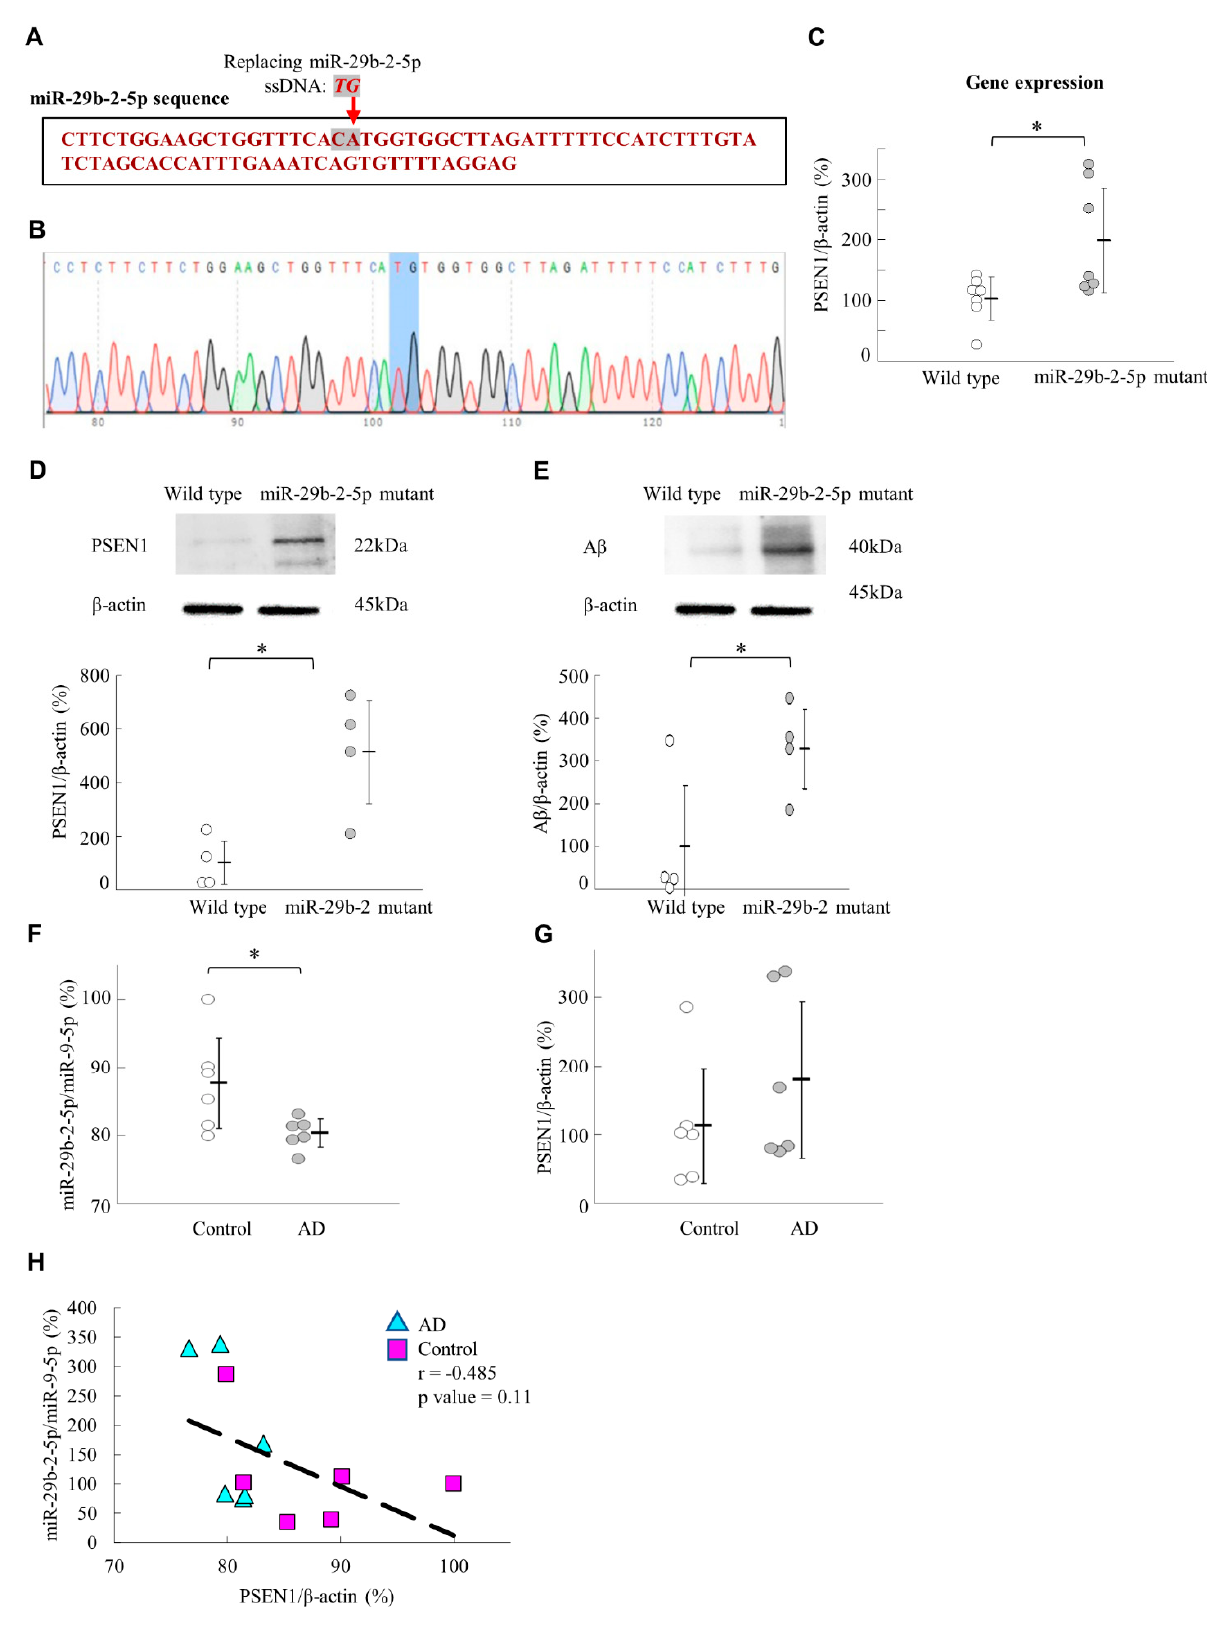
Figure 6. miRNA-29b-2-5p negatively regulates PSEN1 expression and A β . ( A ) The red-labeled nucleotides are wild-type miR-29b-2-5p sequences. In the mutant mice, CA nucleotides were replaced with TG. ( B ) The DNA sequence mapping of miR-29b-2-5p in mir29b-2-5p mutant mice. The C